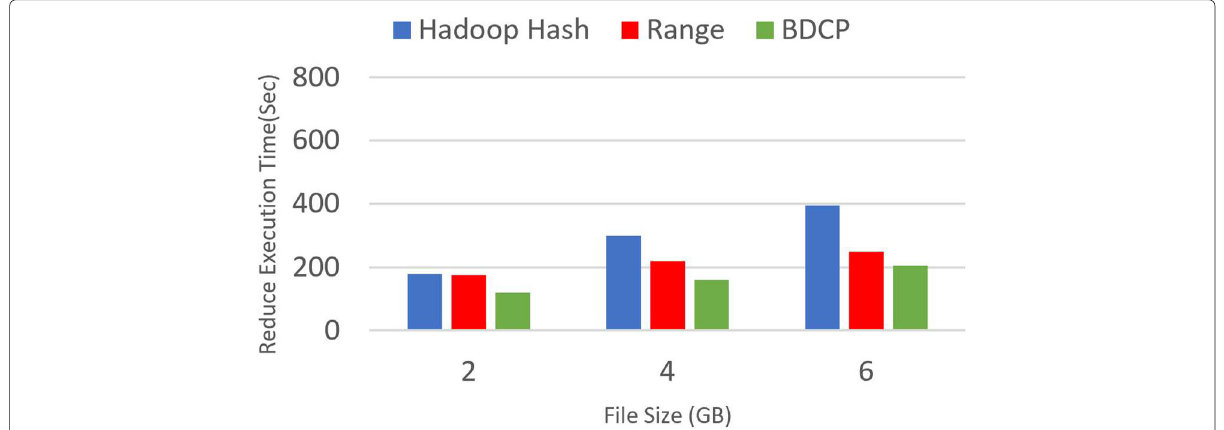
Fig. 14 Word count job on files of sizes, 2, 4, and 6 GB. Skew degree is